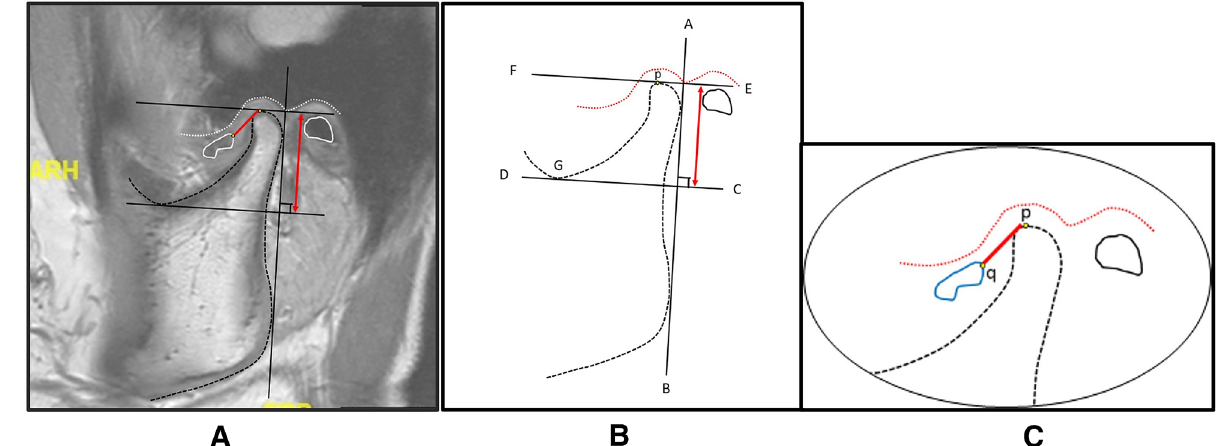
Figure 2. An illustrated diagram demonstrating the key reference points on MRI measurements before surgery. ( A ): A preoperative MRI sagittal view; ( B ): A schematic diagram showing reference points and lines for condylar height measurement; ( C ): A schematic diagram demonstrating reference points and lines for measurement of disc displacement distance.